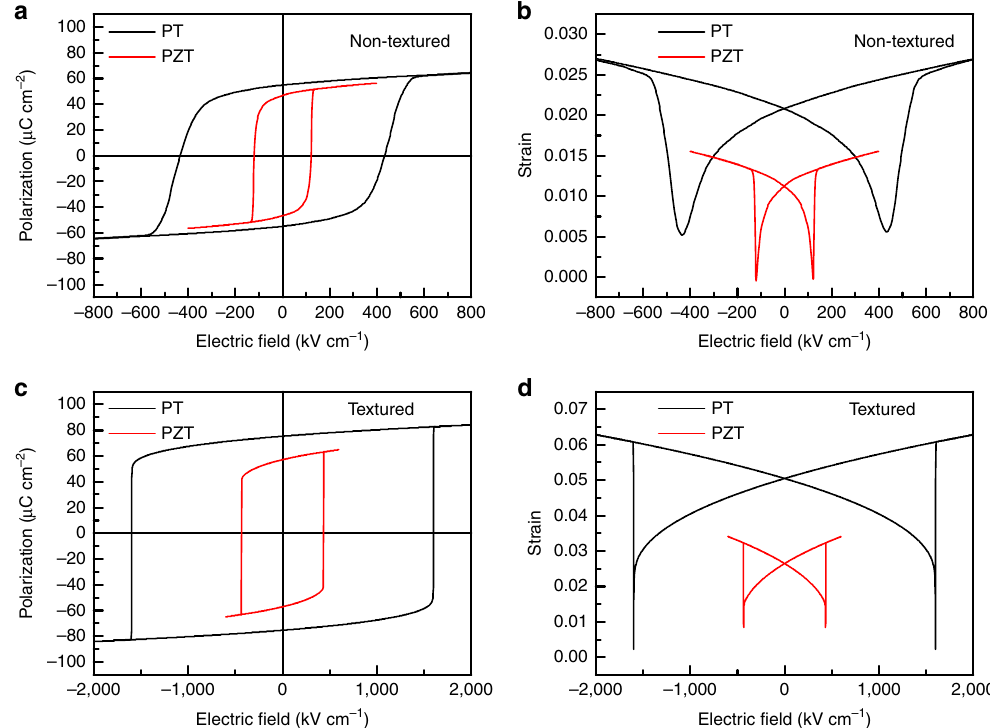
Figure 7 | Phase field simulated polarization-electric field and strain-electric field curves. ( a ) polarization-electric field curves of non-textured PZTand PT ceramics; ( b ) strain–electric field curves of non-textured PZT and PT ceramics; ( c ) polarization-electric field curves of textured PZT and PT ceramics; ( d ) strain–electric field curves of textured PZT and PT